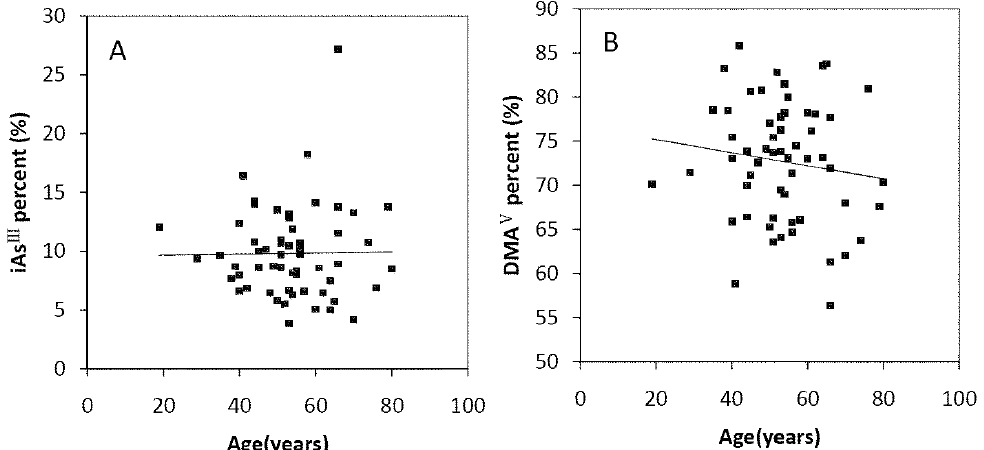
Figure 4. Correlation of age with ( A ) iAs III percent ( R = － 0.06, p > 0.05); ( B ) iAs V percent ( R = 0.195, p > 0.05); ( C ) MMA V percent ( R = － 0.17, p > 0.05); ( D ) DMA V percent ( R = － 0.133, p > 0.05); ( E ) PMI ( R = － 0.021, p > 0.05); ( F ) SMI ( R = － 0.007, p > 0.05) in the